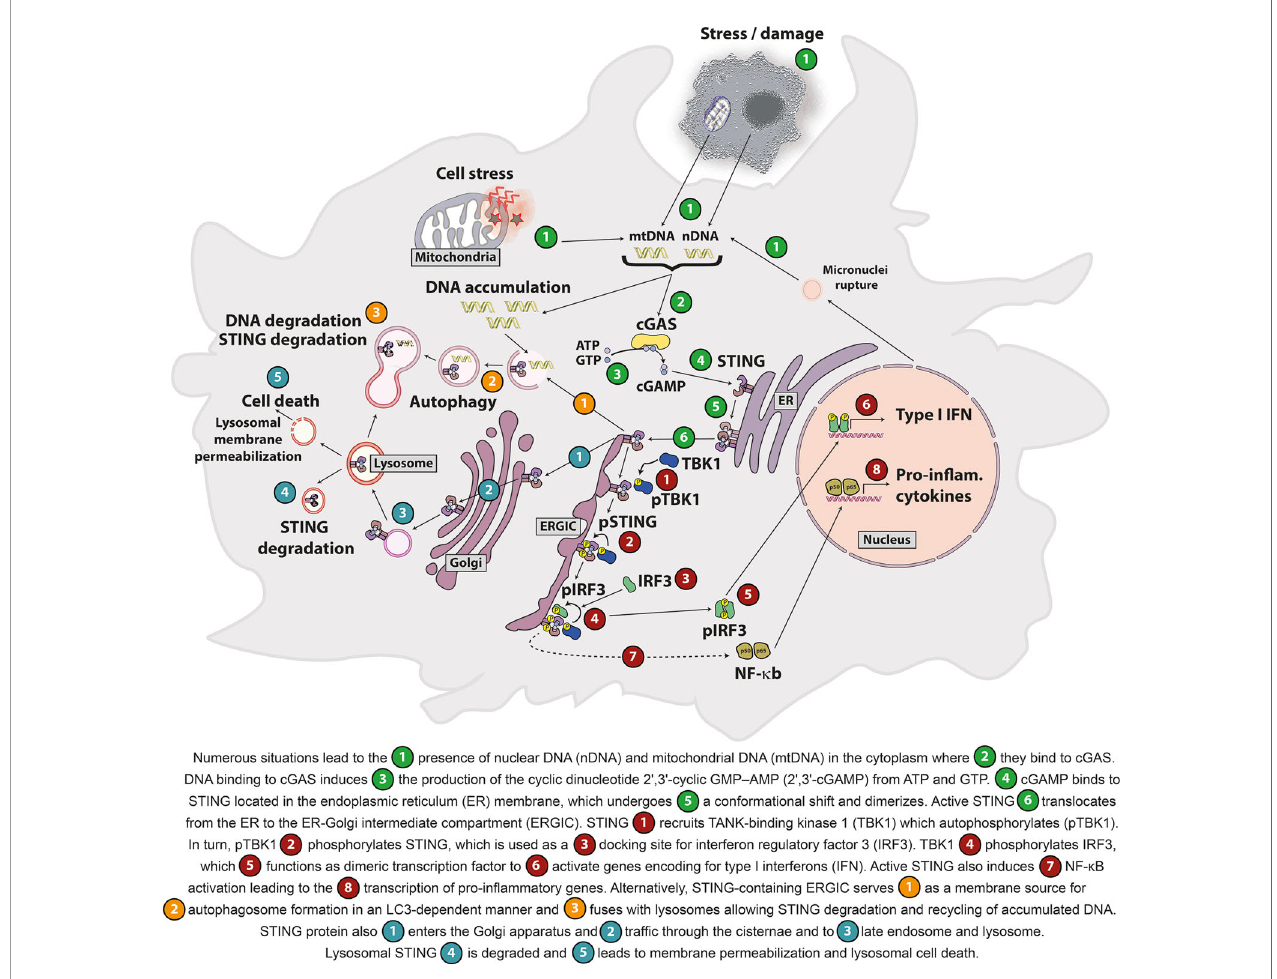
FIGURE 1 | Self-DNA-mediated activation of the cGAS/STING